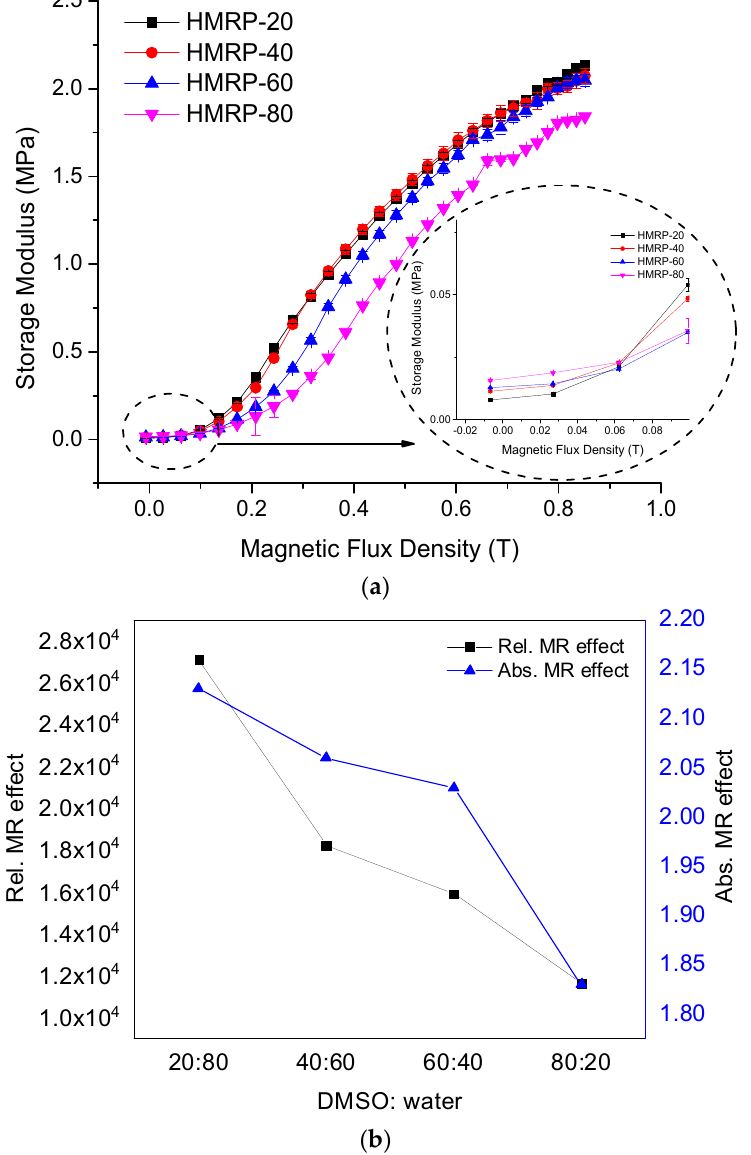
Figure 7. Shear storage modulus of PVA-based MRP samples with the different ratios of DMSO:water ( a ), and the calculated ASTE and RSTE ( b ) of the samples under a continuously changing magnetic flux density.